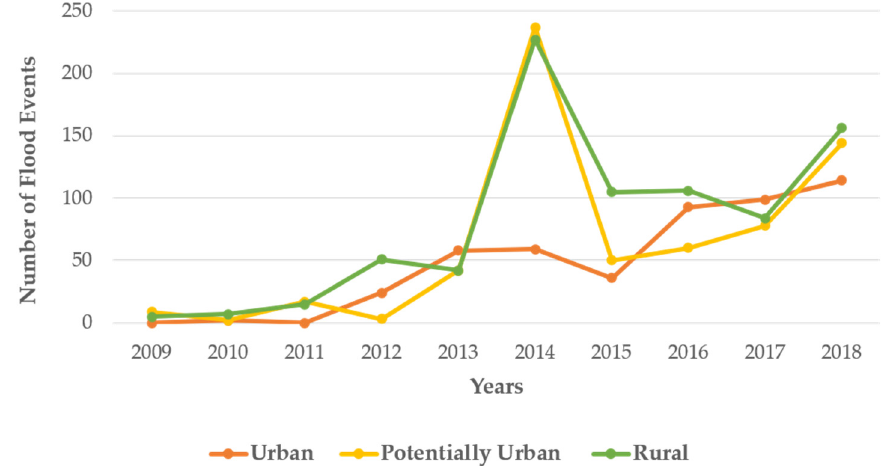
Figure 6. Flood Events in Urban, Potentially Urban and Rural Areas in the North Coast of Central Java 2009–2018. Flood events data in 2009–2011 are highly depend on online news due to limited data from